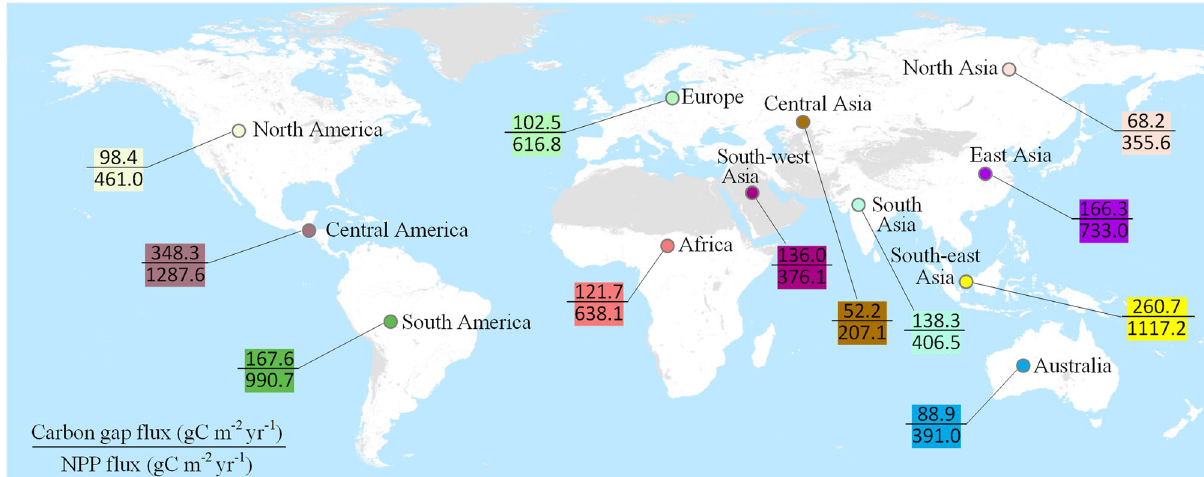
Fig. 2 Carbon gap and NPP density averaged at continent (region) level. The numerator and denominator of each fraction for the continents/regions show carbon gap fl ux/density (gC m − 2 yr − 1 ) and NPP fl ux (gC m − 2 yr − 1 ),